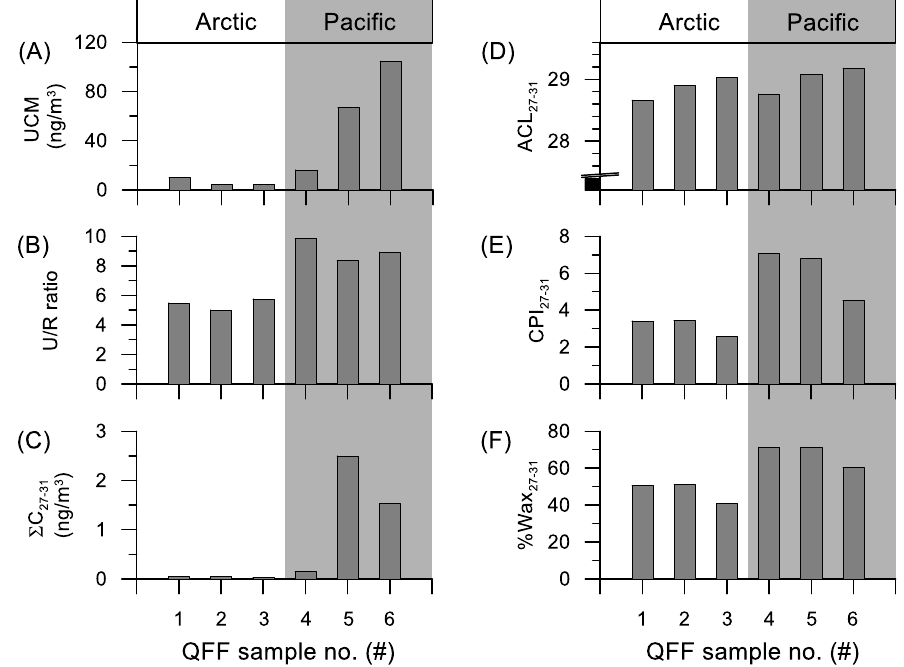
Figure 3. ( A ) Concentration of unresolved complex mix (UCM) hydrocarbons, ( B ) ratio of unresolved to resolved hydrocarbon components (U/R), ( C ) odd-carbon-numbered long-chain n -alkanes in the range of C 27 –C 31 ( Σ C 27–31 ), ( D ) average chain length (ACL 27–31 ), ( E ) carbon preference index (CPI 27–31 ), and ( F ) the percentage of wax n -alkanes (%Wax 27–31 ).